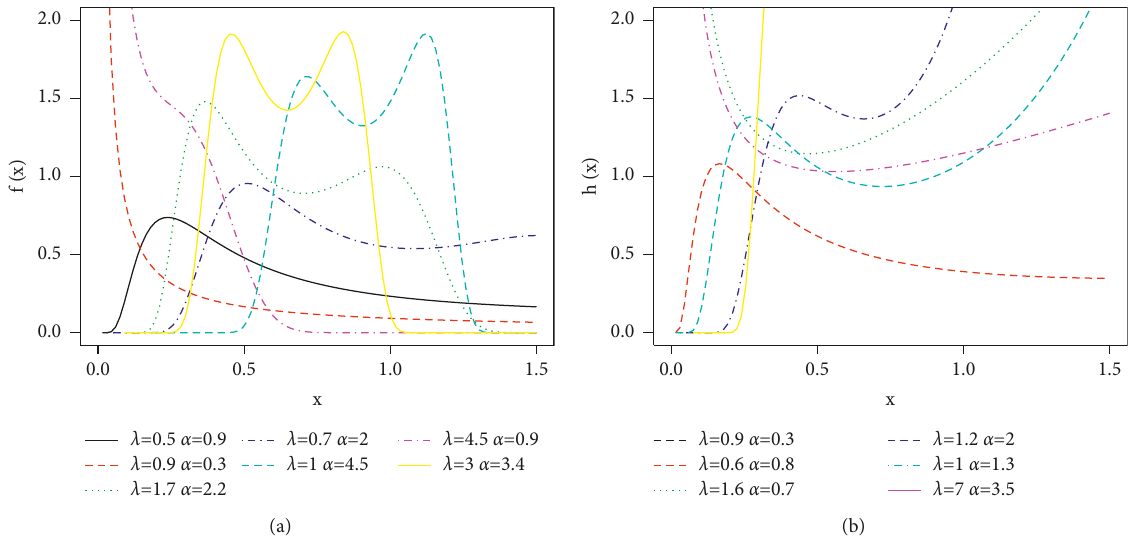
Figure 5: Graphical representation for the plots of the LCW: (a) density and (b) hazard rate for some parametric